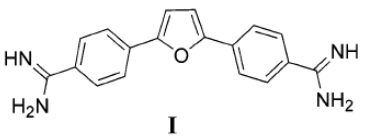
Figure 1. The structure of diamidine furamidine analogue